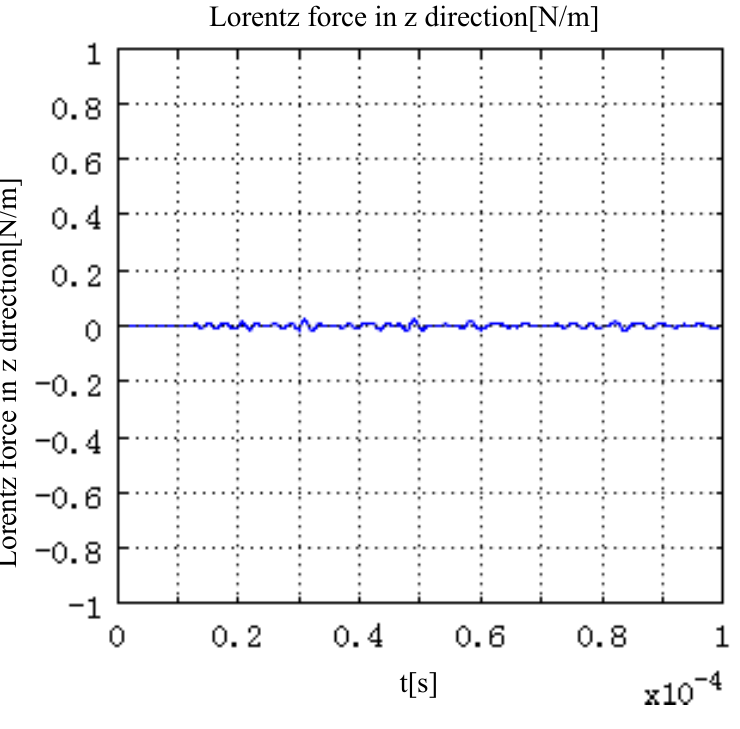
Figure 4. Lorentz force in direction .